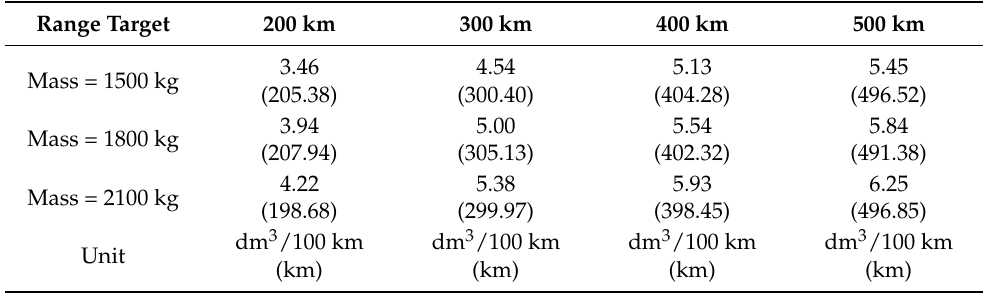
Table A11. Fuel consumption in EREV mode for constant speed drive at 100 km/h.